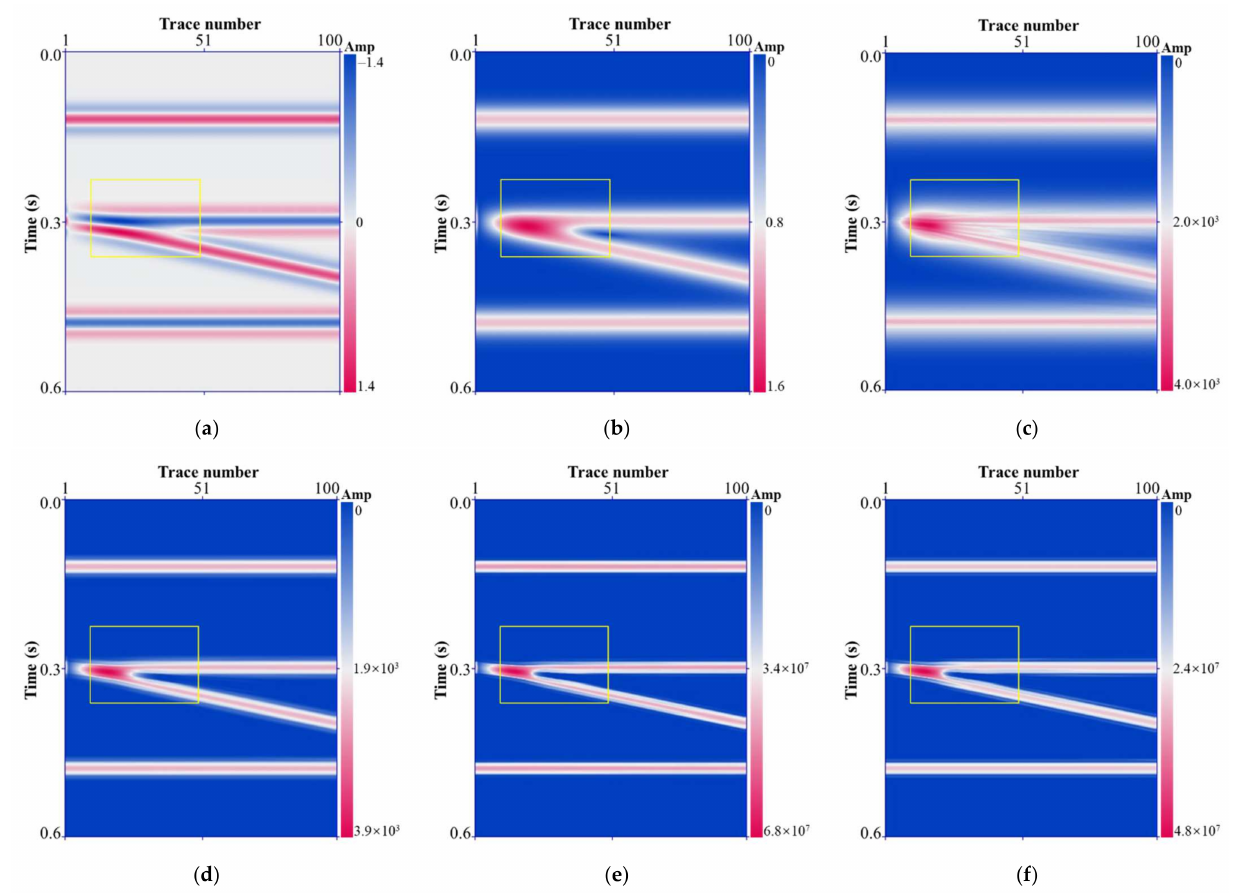
Figure 3. ( a ) Synthetic 2D seismic data. Instantaneous amplitudes obtained by: ( b ) HT; ( c ) GHT with p = 0.4; ( d ) LTFS with p = 0.4, f 1 = 0 Hz, and f 2 = f N = 500 Hz; ( e ) GHT with p = 0.2 (or LTFS with p = 0.2, f 1 = 0 Hz, and f 2 = f N = 500 Hz); ( f ) LTFS with p = 0.2, f 1 = 10 Hz, and f 2 = 100